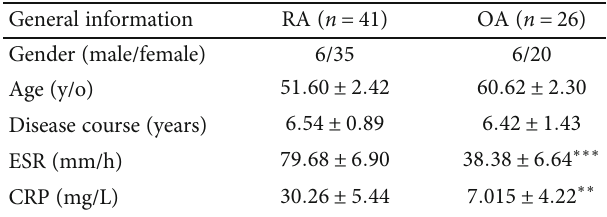
Table 2: General information of patients recruited for IHC in this study.